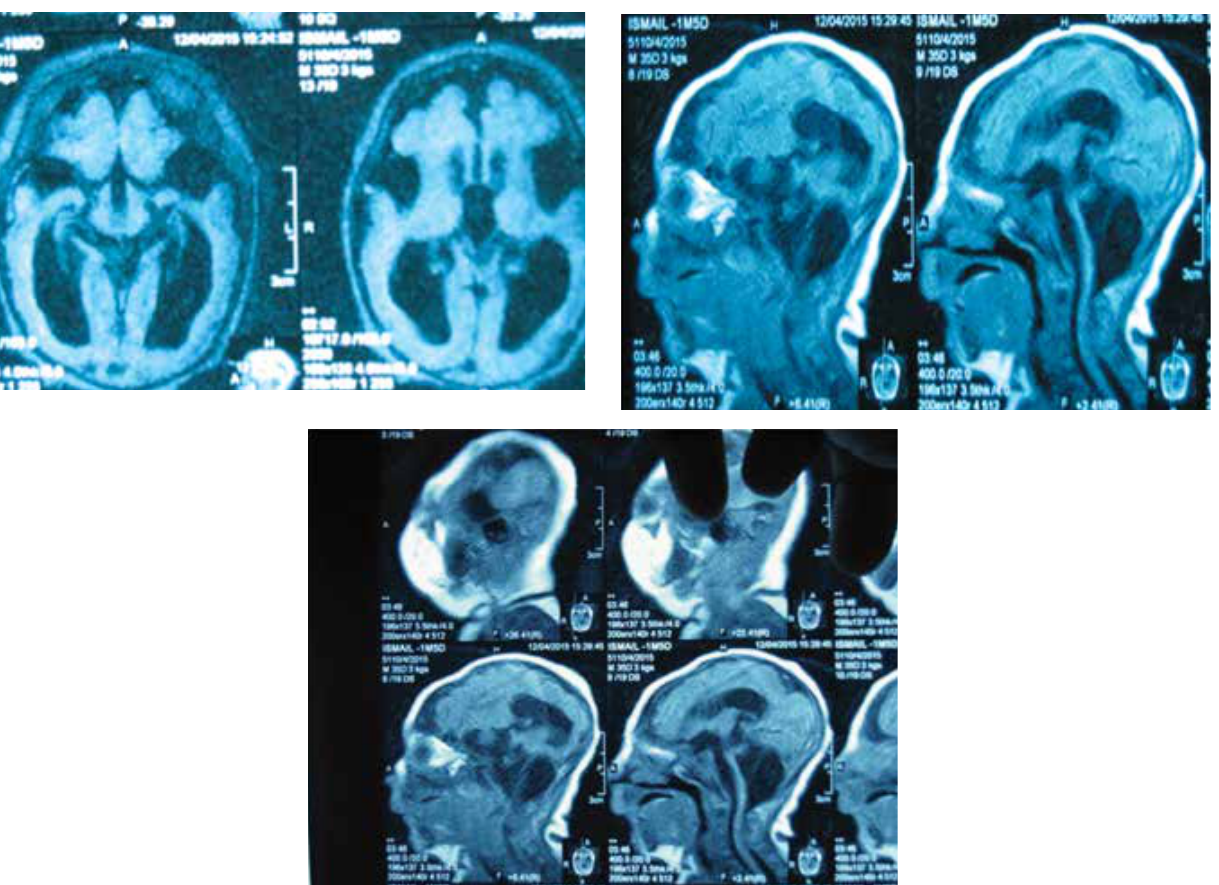
Fig 1. MRI of brain showing hypoplastic and everted cerebellum with a large posterior fossa cyst. Both lateral and 3 rd ventricles are moderately dilated which is suggestive of Dandy-Walker malformation with moderate triventricular hydrocephalus with bilateral cerebral